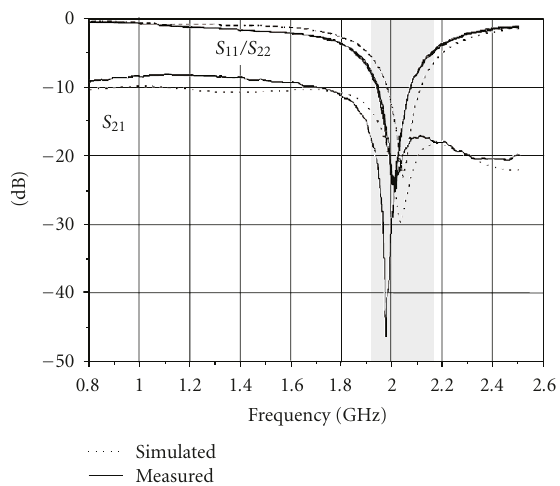
Figure 4: Simulated and measured S -parameters of the two- antenna system with a line between the PIFA shorting strips.